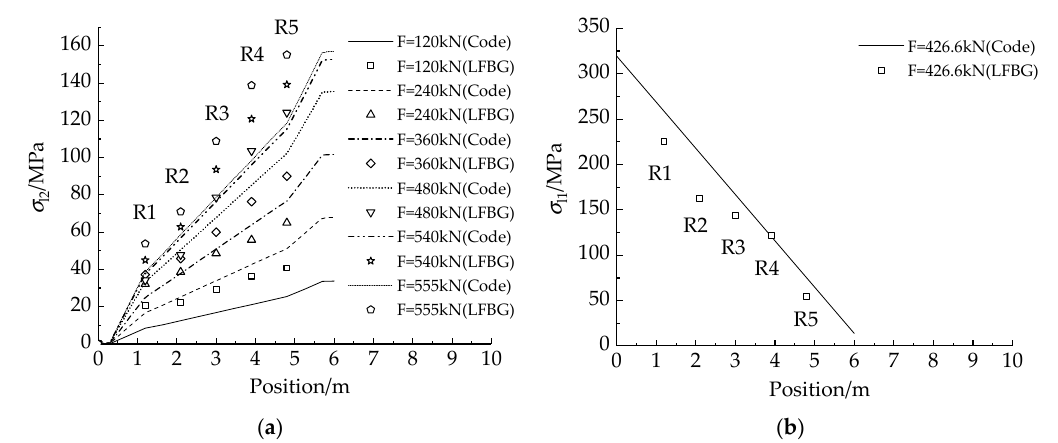
Figure 9. The comparisons of the two calculated losses and the predictions according to the Chinese Code [44]: ( a ) σ l2 ; and ( b ) σ l1 .